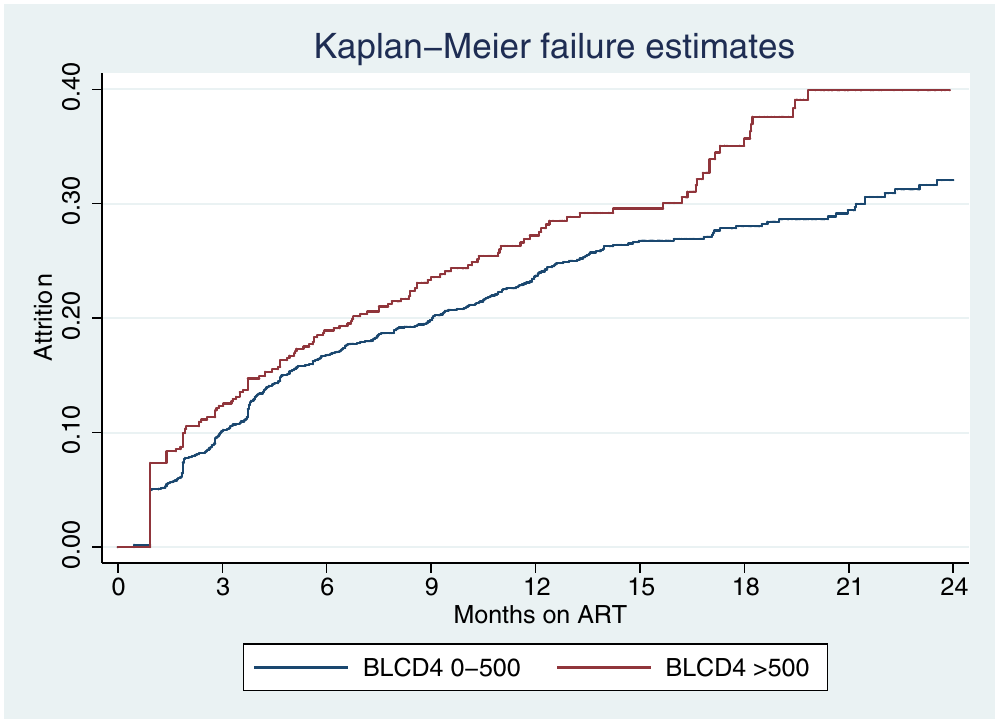
Fig 1. Kaplan Meir failure estimates for attrition stratified by baseline CD4 cell count. BLCD4: Baseline CD4 cell count in cells/ μ L. Log-rank test for equality of survivor functions: P = 0.02.